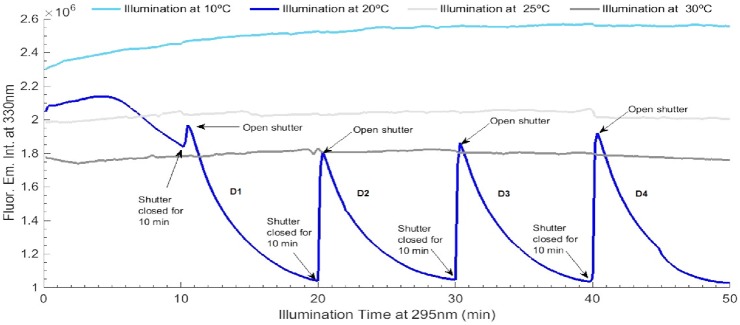
Temperature effect on LYZ photochemistry: at 10°C (light blue), 20°C (dark blue), 25°C (light grey) and 30°C (dark grey), for four open/close cycles of periods of 10 min of excitation followed by 10 min in the dark.Fluorescence excitation and emission wavelengths were fixed at 295 nm and 330 nm, respectively. Excitation slit size was set at 0.5 mm (1.0 μW) for all experiments.